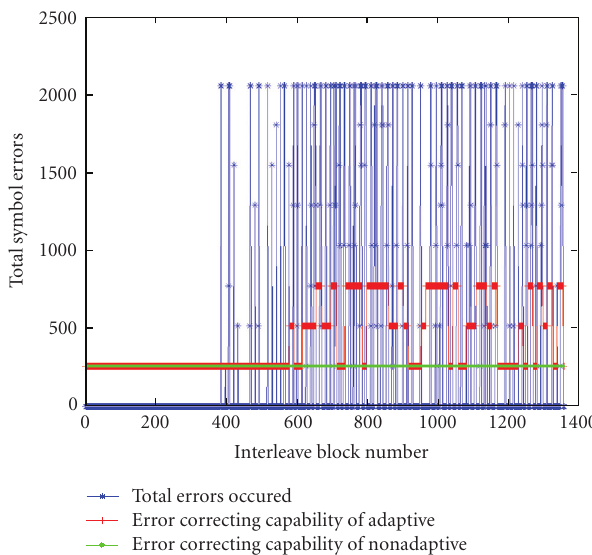
Figure 16: Performance of feedback for “ all ” sequence at 128kbps, random delay 0.012, bu ff er size 500, packet size 256, span 8, PL rate 15.66%.